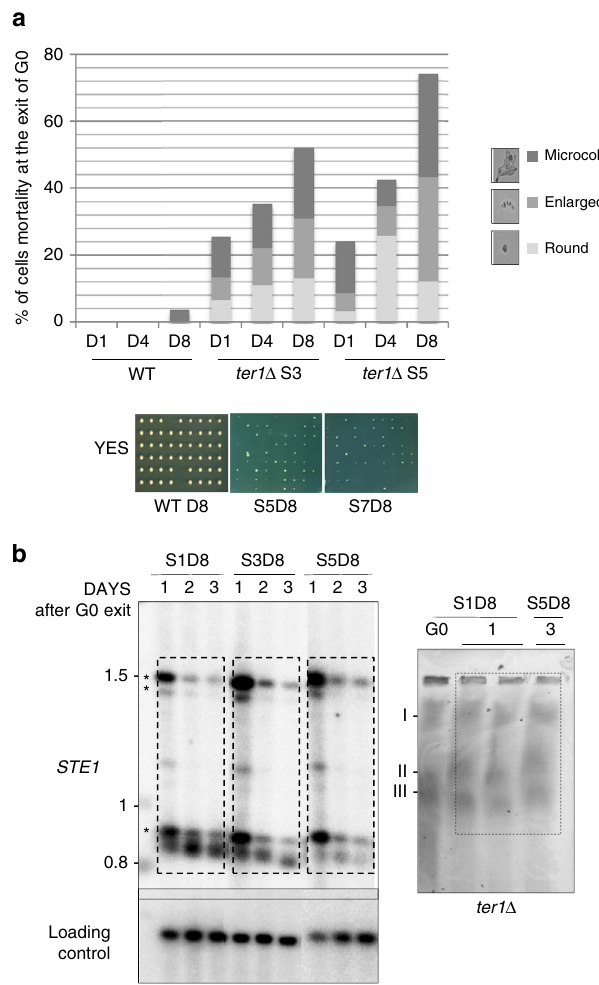
Fig. 8 STEEx are counter selected upon exit from quiescence. a Wild type and ter1 Δ single cells were maintained in quiescence for 1, 4, or 8 days, micromanipulated and plated onto YES plate allowing them to exit quiescence (refer to Fig. 1 for senescence and quiescence). The percentage of cells that were not able to form a colony was plotted. Microscopic observation was performed to determine how cells died when they re-enter into cell cycle. We distinguished single-round cell, enlarge cell, and micro- colony (1 – 20 cells). Round cell died in G0 while enlarged or micro-colony attempted to exit G0. b Left panel, at several time points of the senescence kinetics (S1, S3, and S5) a population of 8-days quiescent cells were allowed to exit G0 by changing medium to YES. Cells were grown for 1, 2, or 3 days in YES medium and collected. Genomic DNAs were prepared from the collected cultures, digested with EcoR I and analyzed by southern blot with a Telo/STE1 and control probes. STEEx are indicated by asterisks. Right panel, pulsed fi eld gel electrophoresis (PFGE) analysis was performed with the indicated samples (S1D8, 1 day in senescence, 8 days in G0, and 1 day after exit; S5D8, 5 days in senescence, 8 days in G0, and 3 days of growth after exit). Gel was stained with ethidium bromide